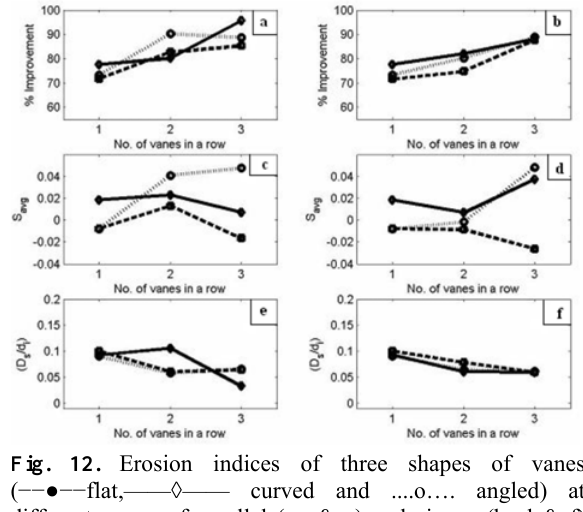
Fig. 12. Erosion indices of three shapes of vanes ( −−●−− flat,—— ◊ —— curved and ....o…. angled) at different arrays of parallel (a,c,& e) and zigzag (b, d & f) pattern installed at 900- bend.